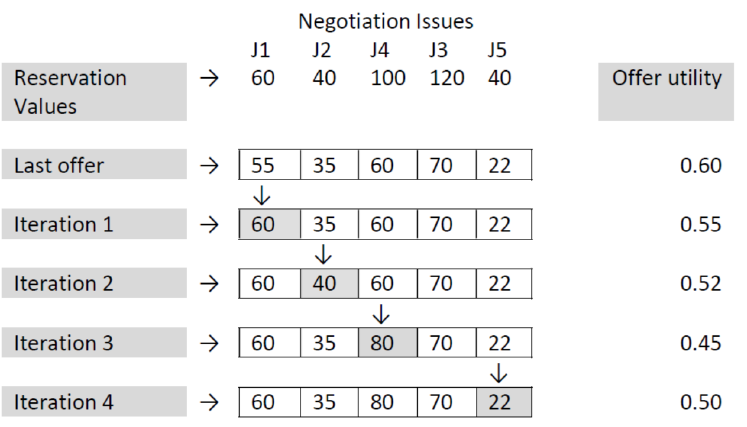
Figure 2. Concession starts with